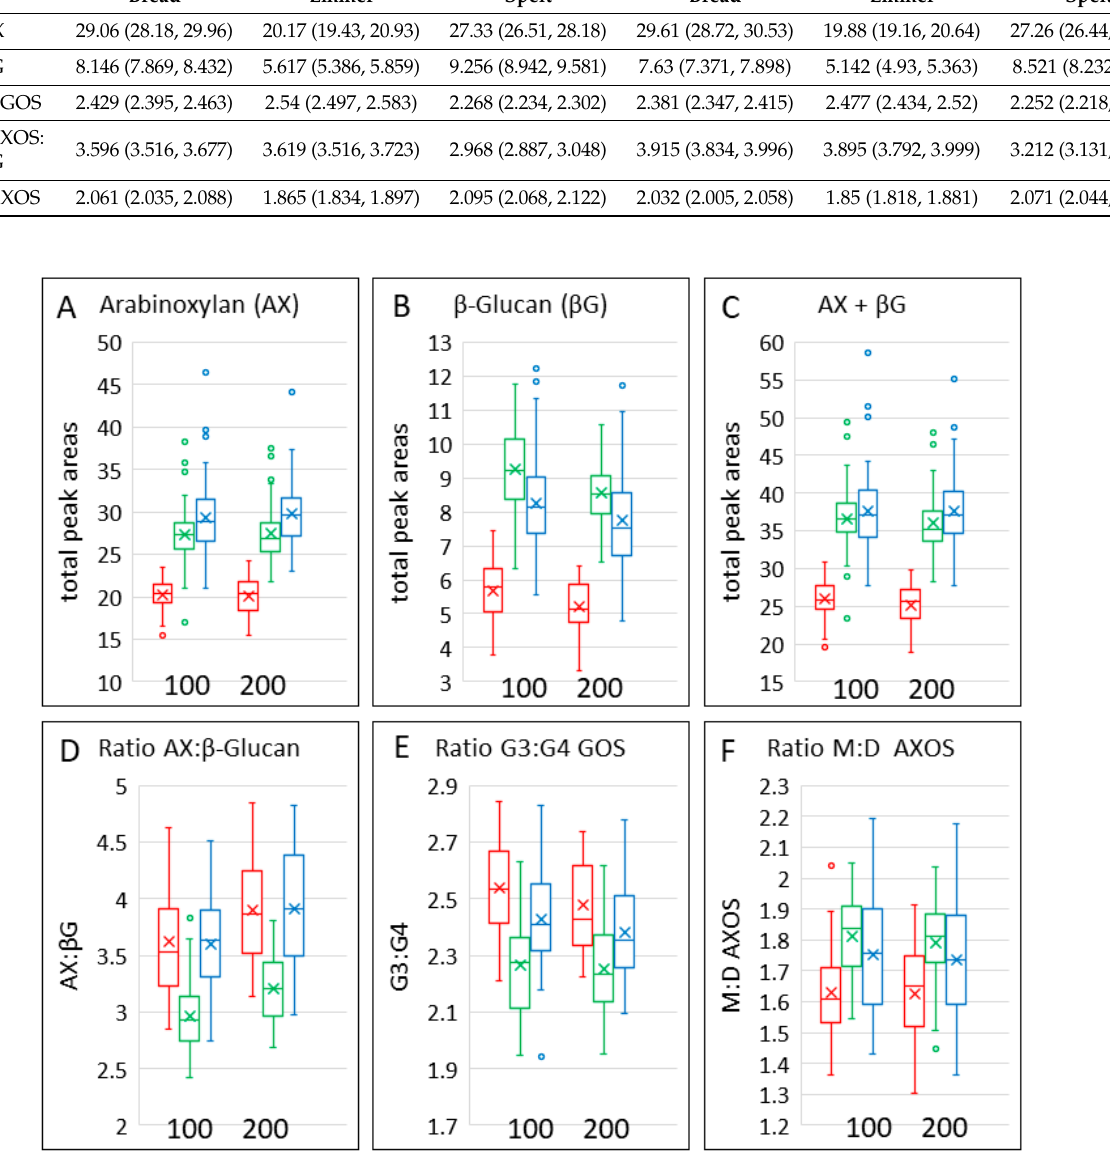
Commented [M5]: Please update the figure 5.